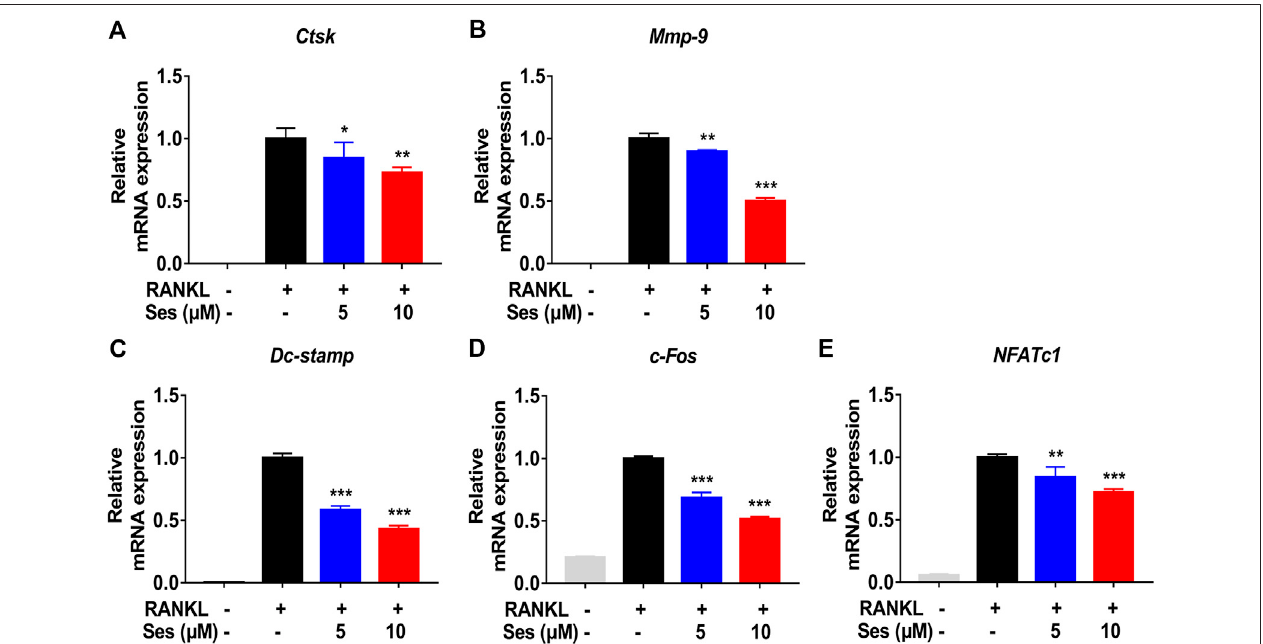
FIGURE4| Sesinhibitstheexpression ofosteoclast-speci fi cgenes invitro . (A – E) Theexpression levelsoftheosteoclast-related speci fi cgenes Ctsk , Mmp-9 , Dc- stamp , c-Fos and NFATc1 were analyzed by qPCR. The above data are expressed as the mean ± SD; n (cid:1) 3; * p < 0.05, ** p < 0.01, and *** p < 0.001. Ses, sesamolin; RANKL,receptoractivator ofnuclearfactor- κ Bligand; Ctsk ,cathepsinK; Mmp-9 ,matrixmetalloproteinase-9; Dc-stamp ,dendriticcell-speci fi ctransmembraneprotein; c-Fos , Proto-oncogene C-Fos; NFATc1 , nuclear factor of activated T cells